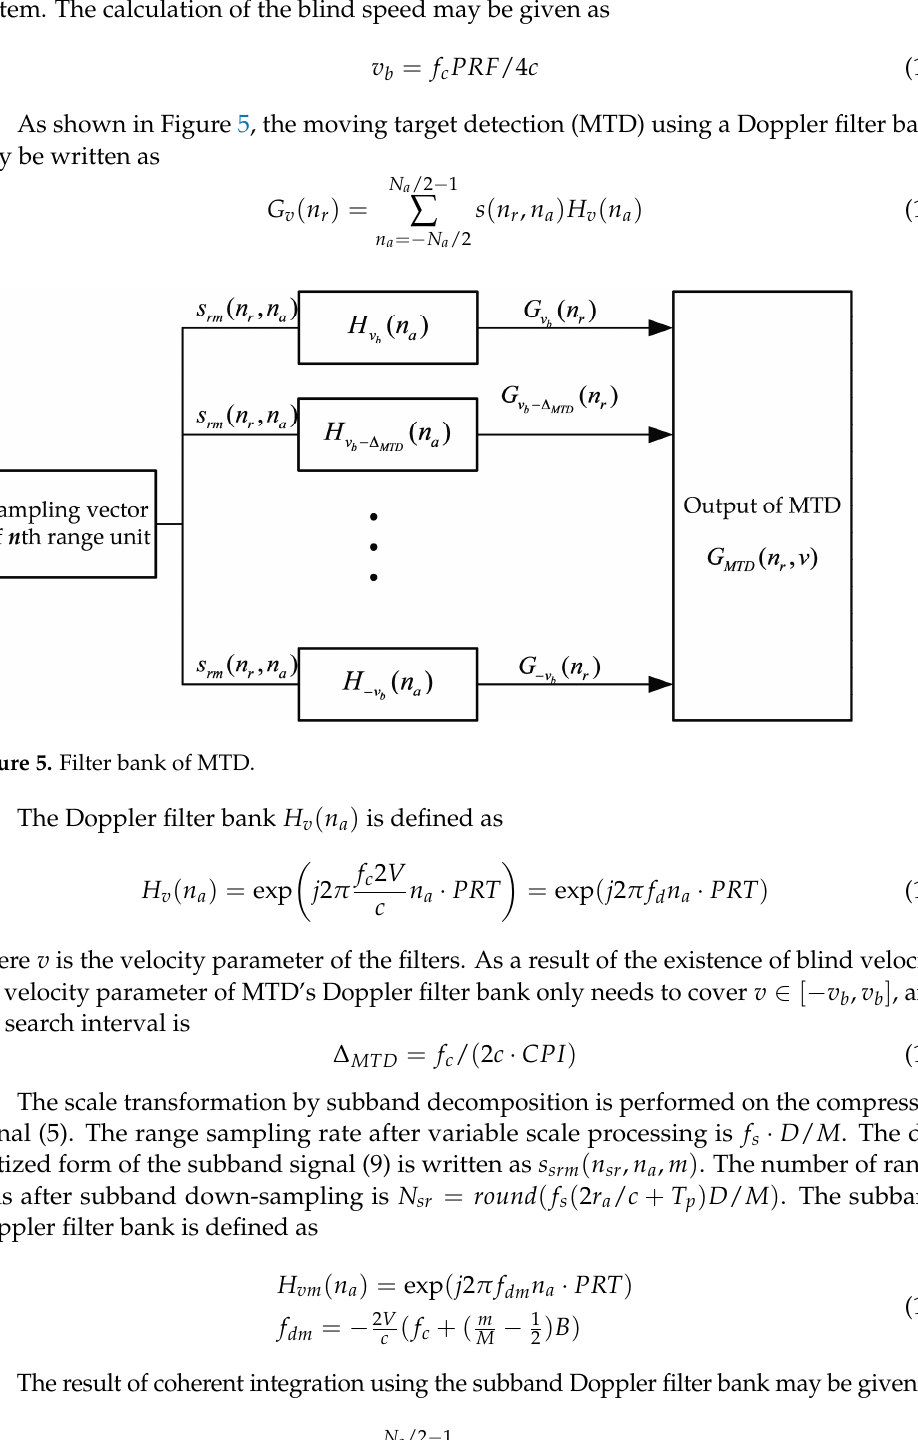
6 of 20 Figure 4. Comparison of signals after different scale transformations.